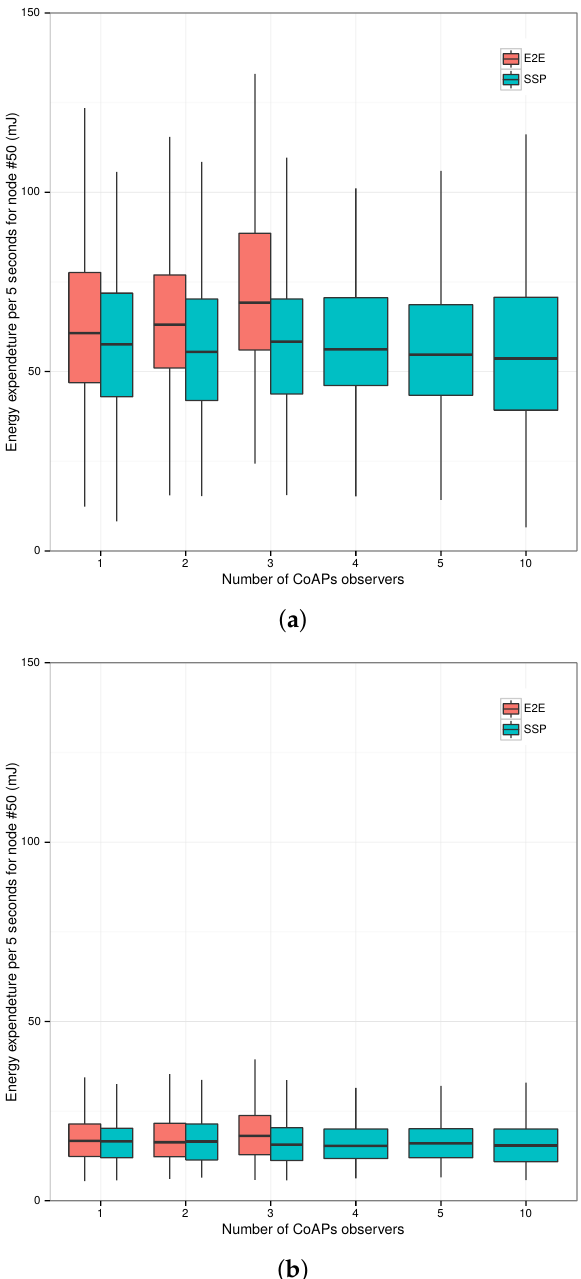
Figure 9. Total energy expenditure for Node #50 per five seconds interval for end-to-end (E2E) CoAPs observation versus CoAPS observation through the Smart Service Proxy (SSP). ( a ) One-second notification interval; ( b ) five-second notification